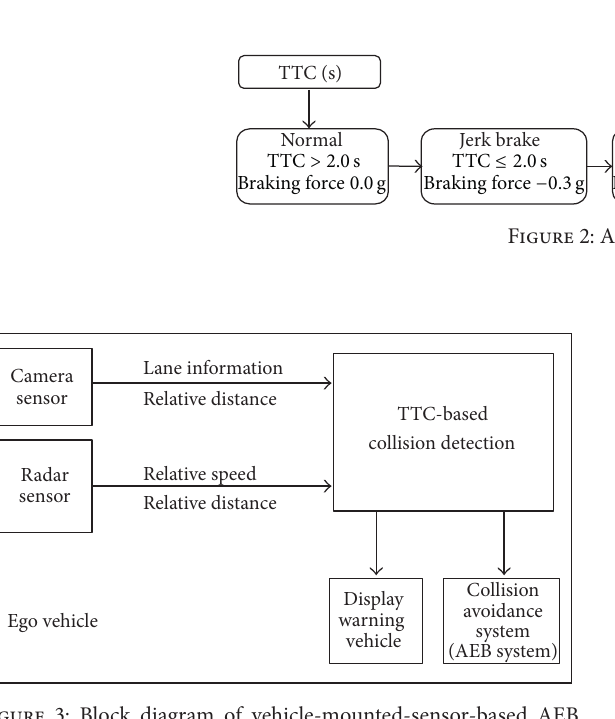
Figure 3: Block diagram of vehicle-mounted-sensor-based AEB